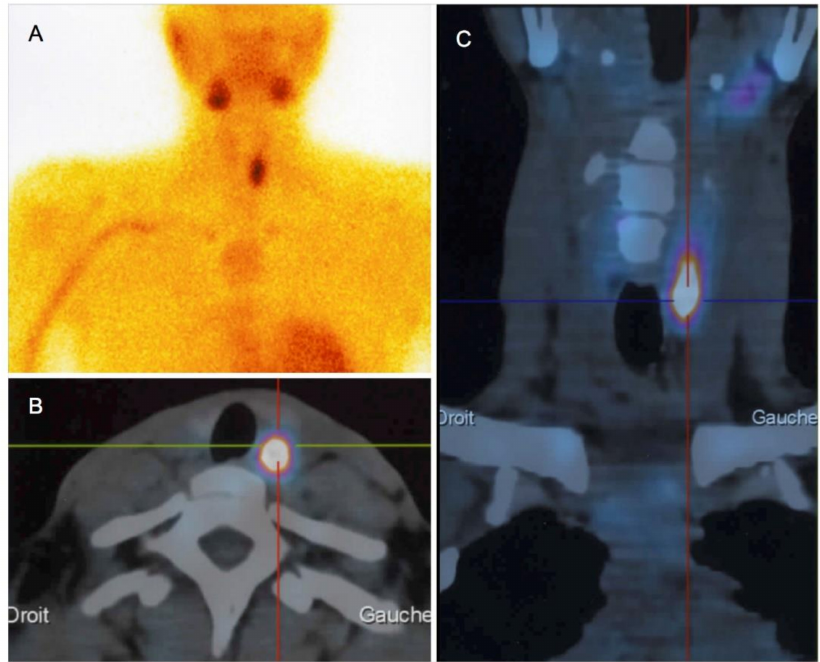
Figure 1. Tc99m-sestamibi scintigraphy ( A ) polled to computed tomography scans (axial ( B ) and coronal sections ( C )) in a 30-year-old woman with pHPT and a 26-mm